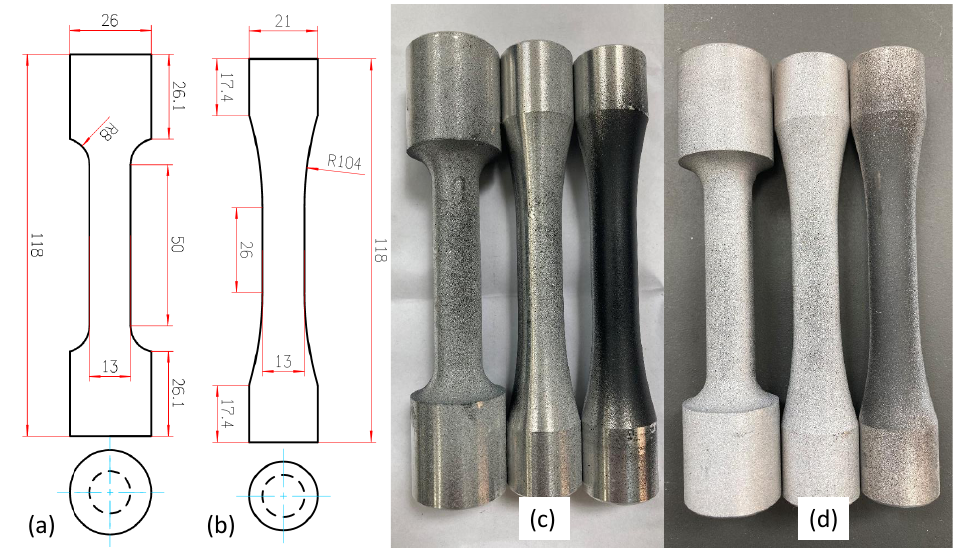
Figure 2. Geometries and pictures of static and fatigue specimens of GC and LPBF: ( a ) geometry of the static specimen, ( b ) geometry of the fatigue specimen, ( c ) static and fatigue specimens of GC, and ( d ) static and fatigue specimens of